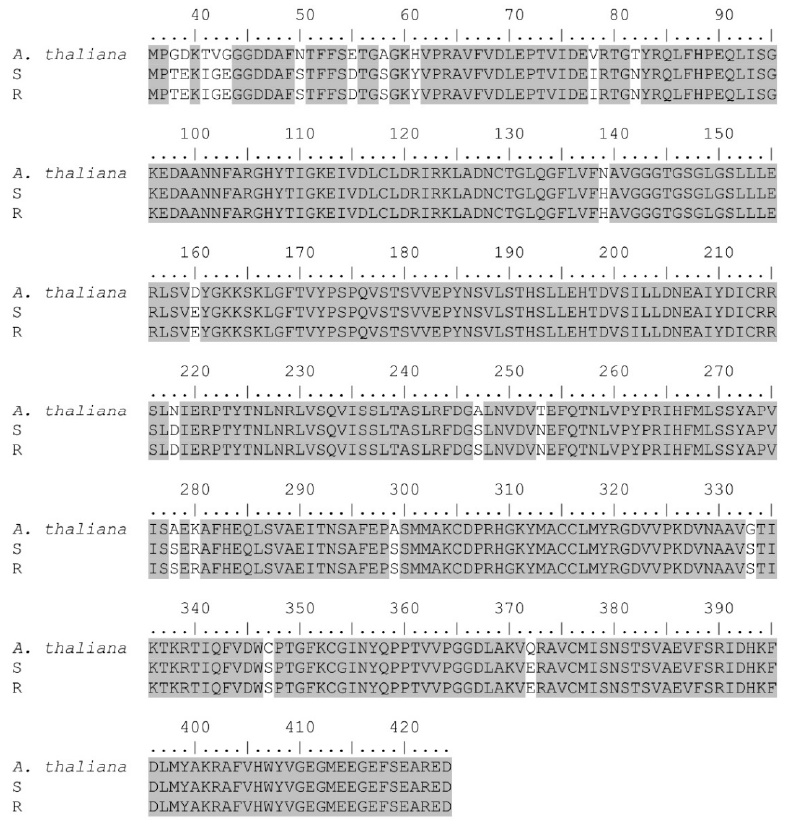
Figure 3. Partial protein sequence alignment of α - tubulin gene of trifluralin-susceptible (S) and resistant (R) A. palmeri accessions. Sequences were aligned to that of the A. thaliana (AT4G14960) α - tubulin gene. Highlighted color indicates homology among the different sequences.